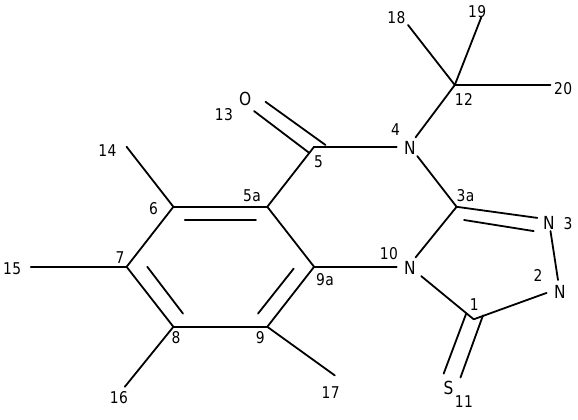
Figure 1a . Numbering of the model compound 1 .